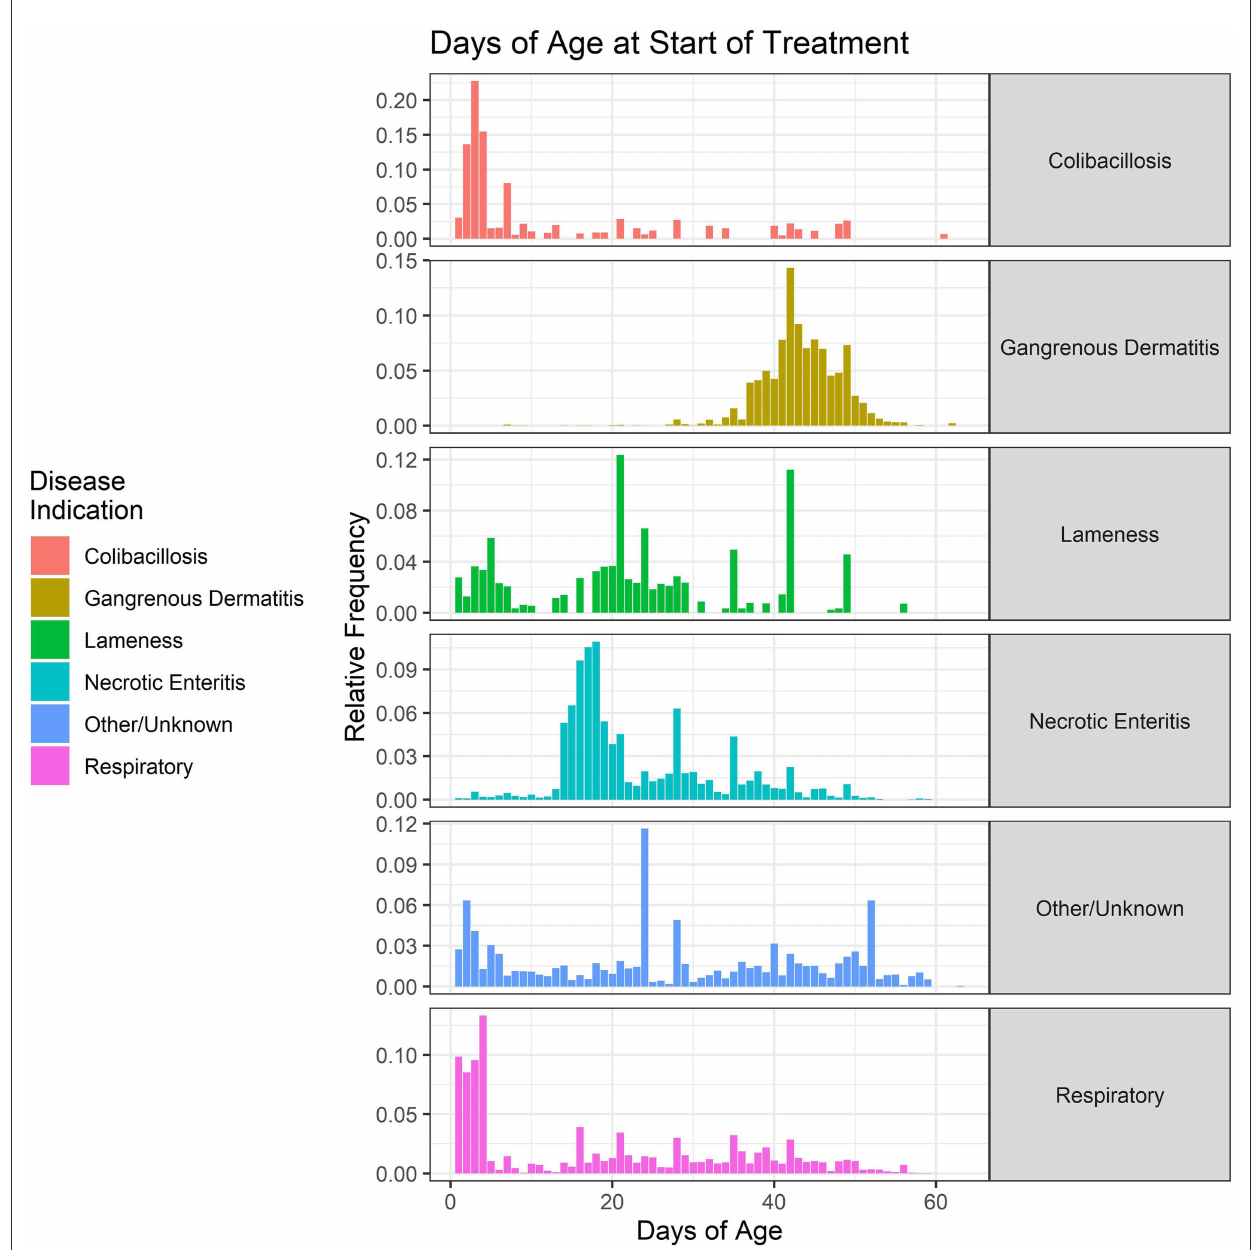
FIGURE8 Age (in days) of the start of antimicrobial administrations in the water of broiler chickens by disease indication, 2018–2021. Each disease indication panel depicts the relative frequency of antimicrobial starting ages (in days) for the respective disease.